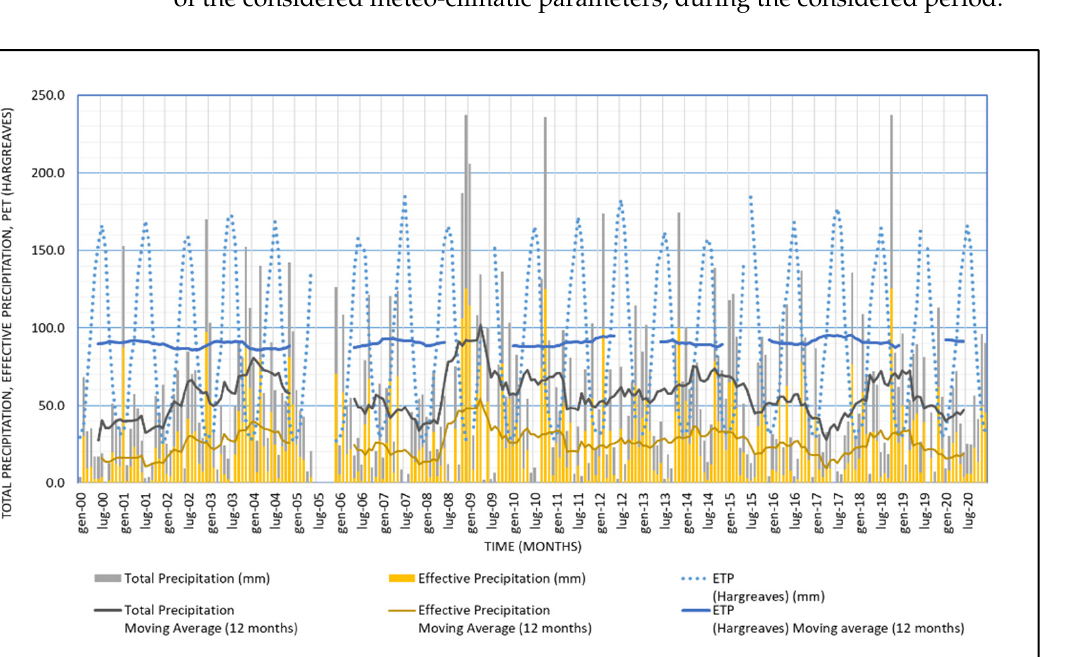
Figure 4. Monthly elements of the hydrological balance in the area under investigation. Effective precipitation and the potential evapotranspiration (PET) were assessed based on [50] and the Hargreaves formula [51], respectively. Precipitation and temperature data were downloaded from the Hydrological Annals published by the Apulian Civil Protection [52].